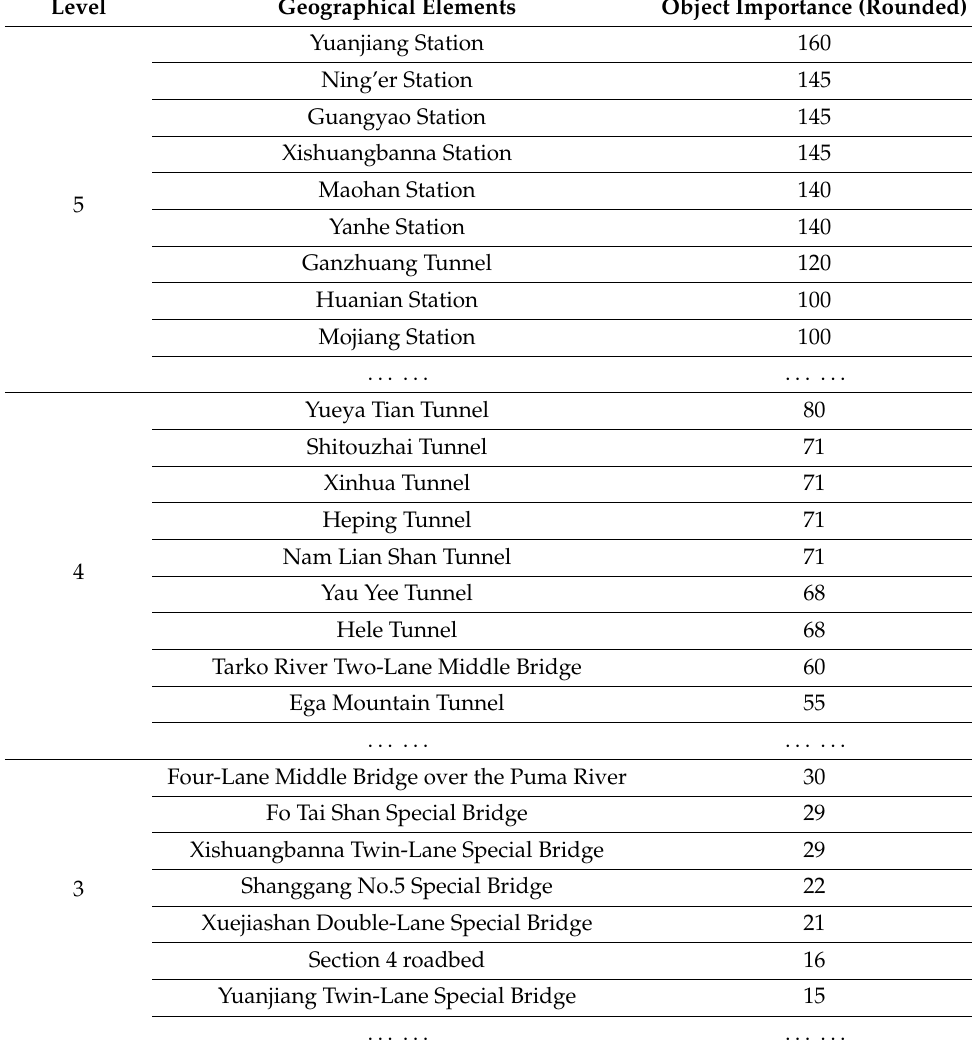
Table 4. Object importance ranking